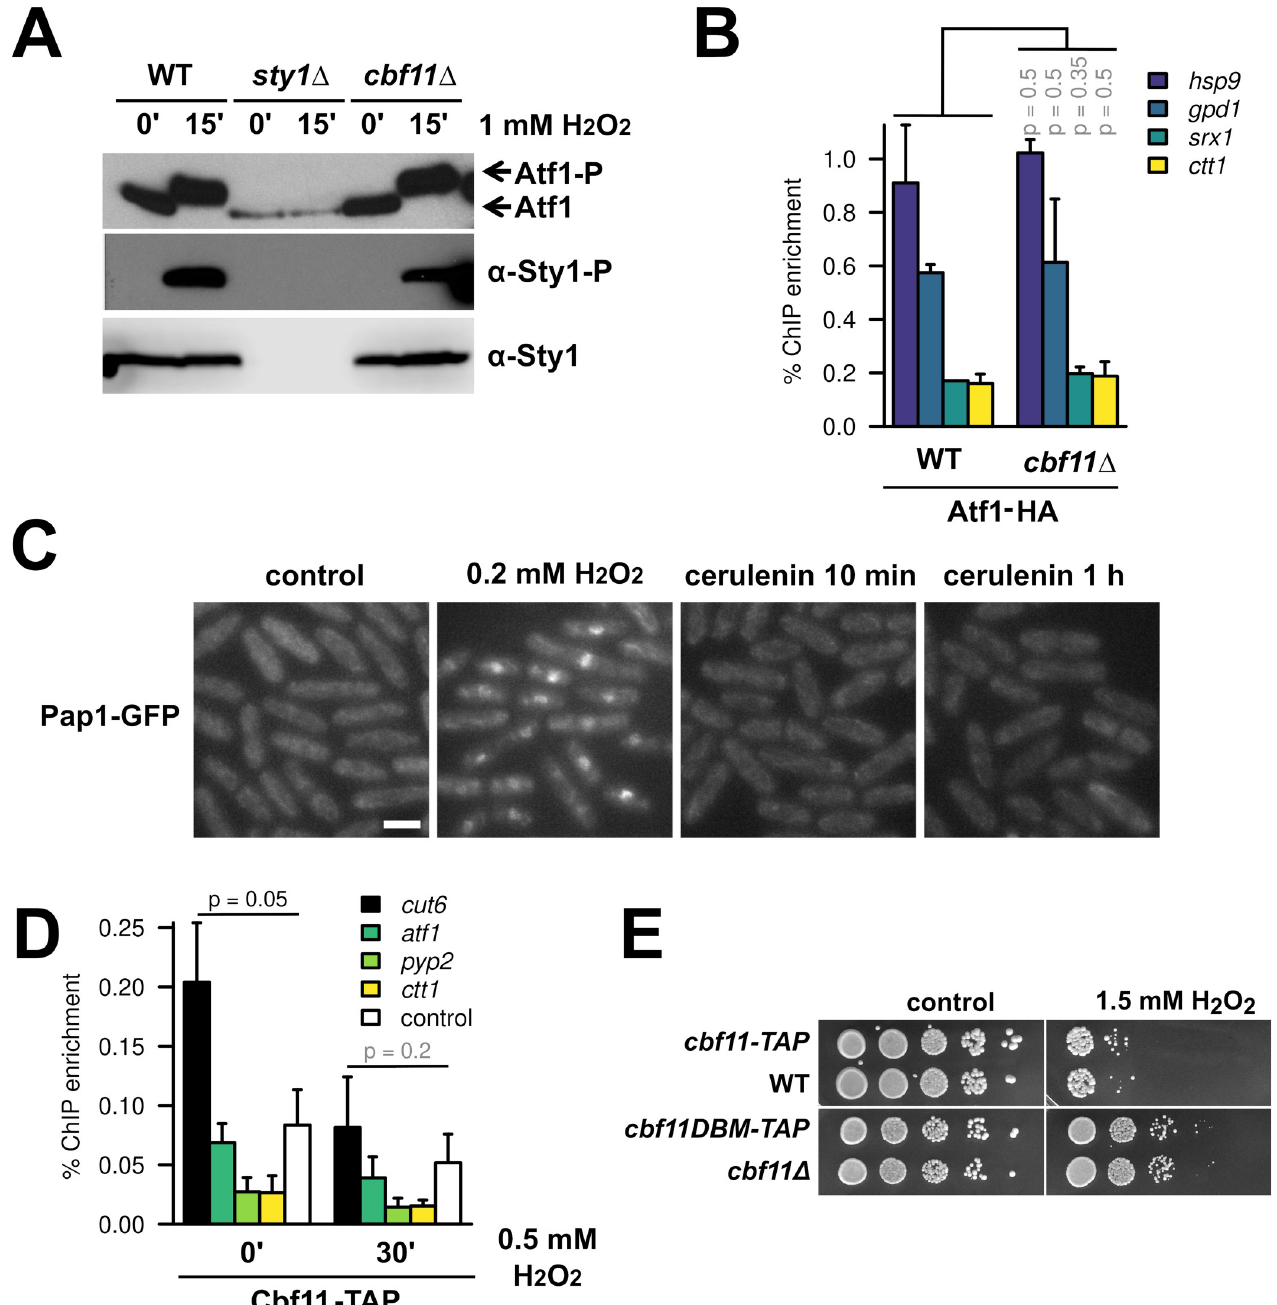
Fig 3. Cbf11 likely affects stress-gene expression indirectly. (A) Western blot analysis of Atf1 and Sty1 phosphorylation in WT, sty1 Δ , and cbf11 Δ cells treated or not with 1 mM H 2 O 2 for 15 min in YES medium. Atf1 phosphorylation manifests as retarded migration through the gel. (B) Recruitment of Atf1 to the indicated stress-gene promoters was analyzed by ChIP-qPCR in untreated cells grown in EMM medium. Mean and SD values of two independent replicates are shown. Two-sided Mann-Whitney U test was used to determine statistical significance. (C) Pap1-GFP localization was observed in formaldehyde-fixed cells grown to exponential phase in YES using epifluorescence microscopy. Cells were either untreated (control), treated with 0.2 mM H 2 O 2 for 25 min as a stressed control or treated with 20 μ M cerulenin for 10 min and 1 hour to inhibit FA synthesis. Scale bar 5 μ m. (D) Recruitment of Cbf11 to the indicated stress-gene promoters was analyzed by ChIP-qPCR in cells treated or not with 0.5 mM H 2 O 2 for 30 min in YES. The cut6 promoter is a positive control for Cbf11 binding [17];”control” is an intergenic locus with no Cbf11 binding (Chr I: 1,928,359–1,928,274). Mean and SD values of three independent replicates are shown. One-sided Mann-Whitney U test was used to determine statistical significance; since no stress promoter loci showed signal higher than the negative control locus, these loci were not tested statistically. (E) Survival and growth under oxidative stress of WT, cbf11 Δ , cbf11-TAP , and cbf11DBM-TAP cultures spotted on YES plates containing 1.5 mM H 2 O 2 .